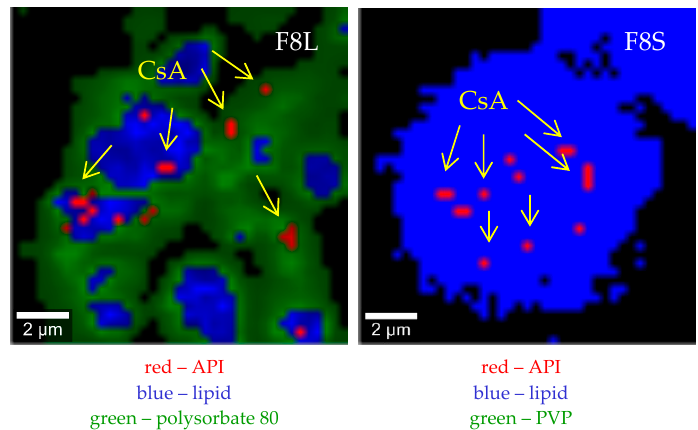
Figure 7. Raman maps (100× resolution) of SLM placebo and with the API formulations prepared “ d e novo” (FL) and after spray drying (FS) with Compritol (F1, F3 and F5) or stearic acid (F8).